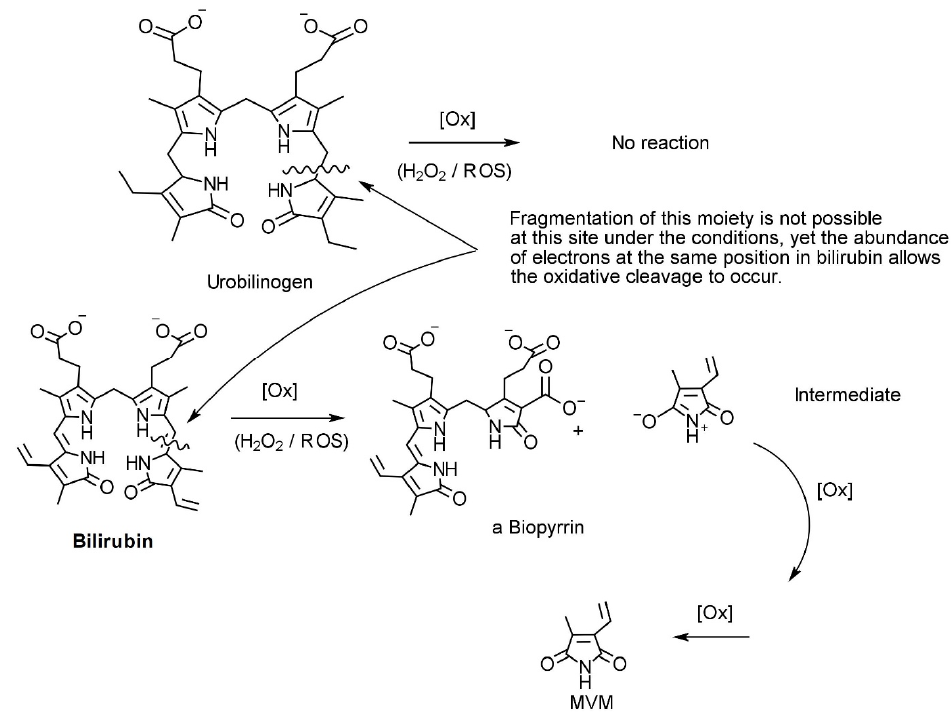
Figure 2. Potential pathways for oxidation of urobilinogen and bilirubin by reactive oxygen species (ROS) such as peroxide.